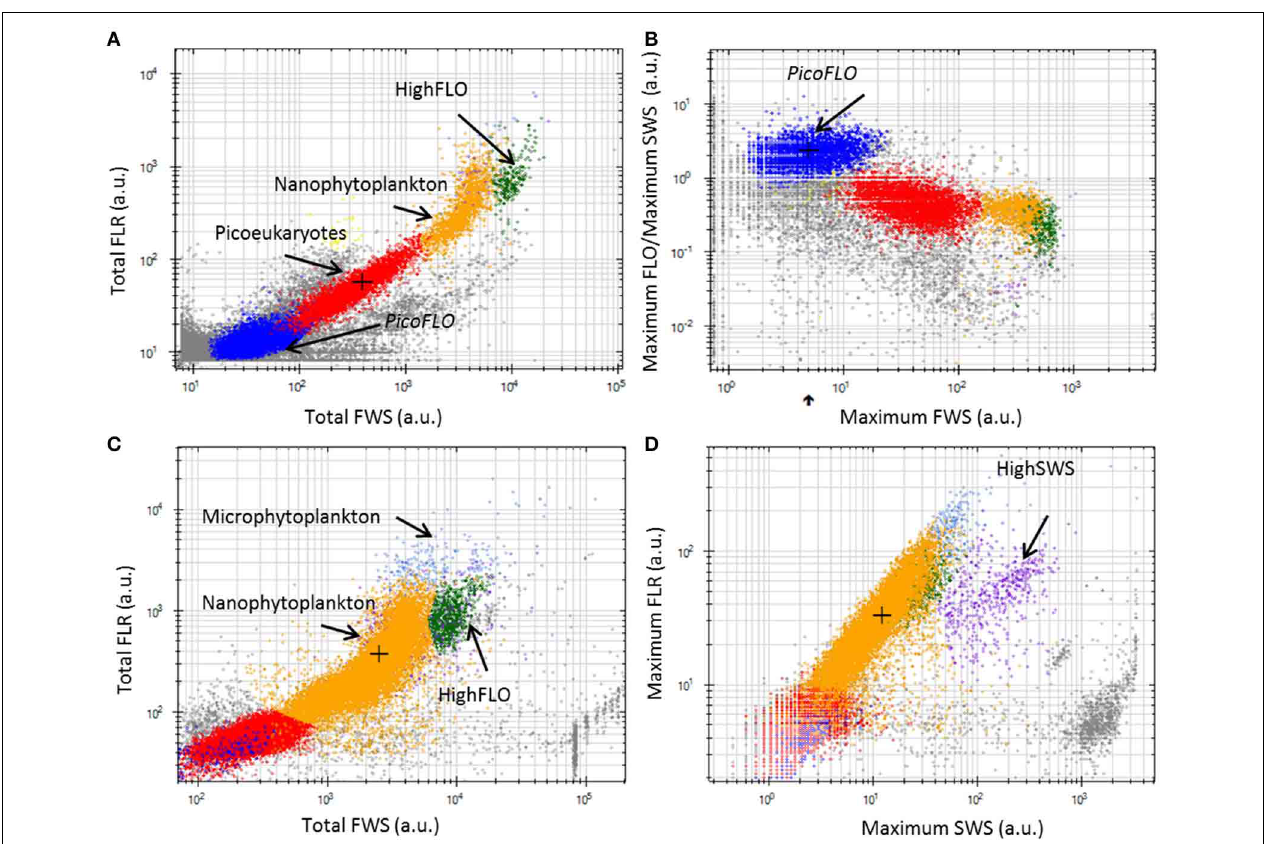
FIGURE 3 | Cytograms from the CytoClus software of samples analyzed with the CytoSense. (A) Cytogram of Total red fluorescence [Total FLR (a.u.)] vs. Total forward scatter [Total FWS (a.u.)] with a red fluorescence trigger level of 7mV allowing identification of PicoFLO, picoeukaryotes, nanophytoplankton, and HighFLO clusters. (B) Cytogram representing the ratio Maximum orange fluorescence/Maximum sideward scatter [Maximum